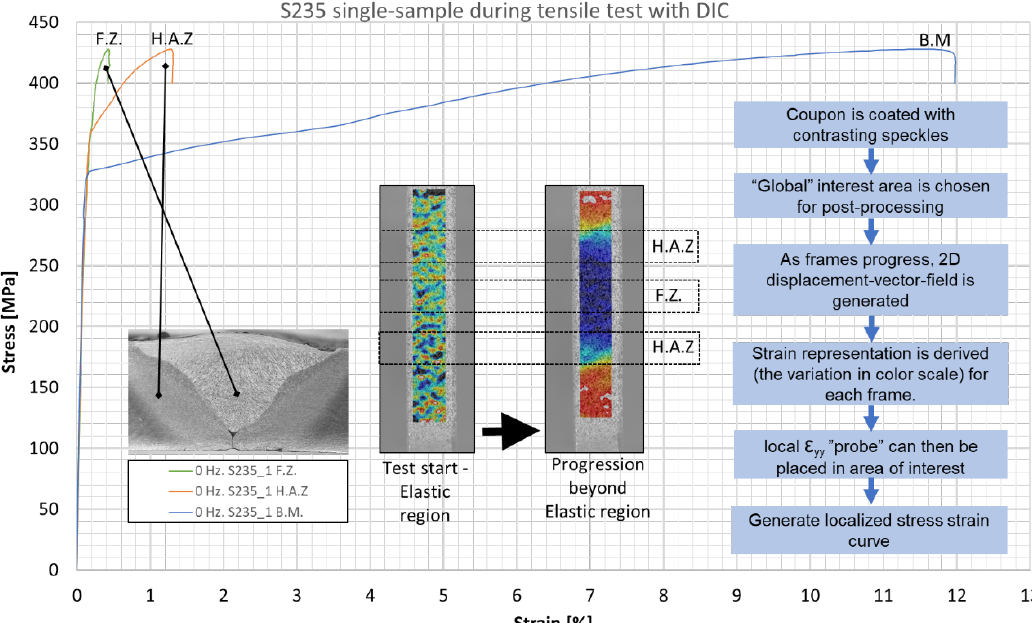
Figure 11. Illustration of the procedure for tensile test testing with digital image correlation (DIC). A digital “strain gage” is p laced at five points along the global area of interest (FZ × 1, HAZ × 2, BM × 2). The results are averaged and three lines are plotted, one for each zone. These plots are all from the same sample, hence, the ultimate tensile strength (UTS) is that of the weakest area of the sample.